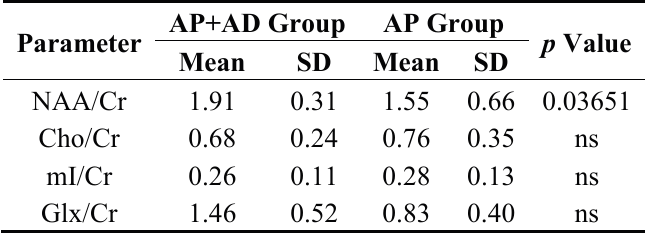
Table 4. Comparison of substance concentration ratios in left